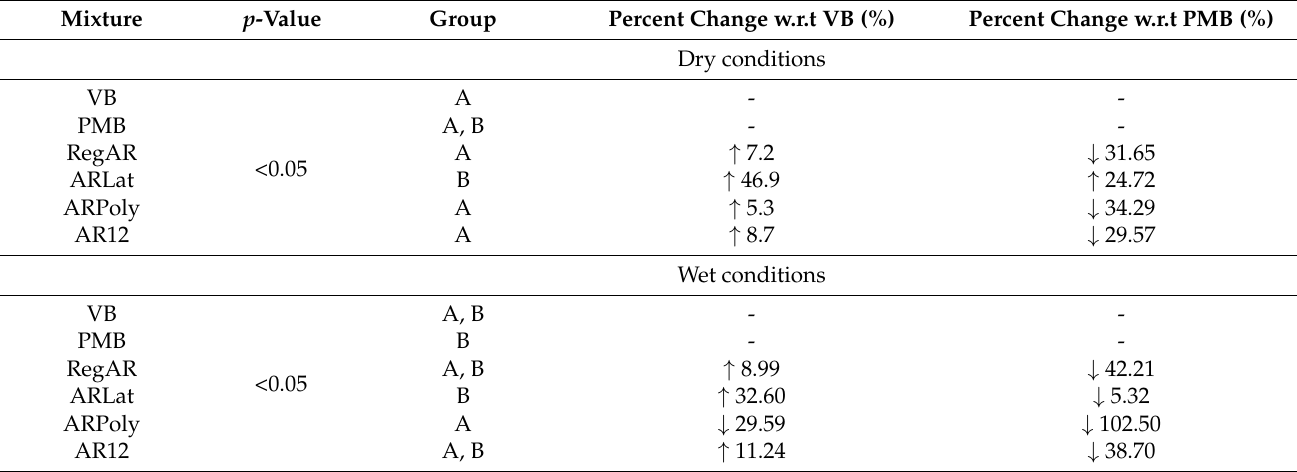
Table 5. Statistical analysis for the abrasion resistance (parametric test).